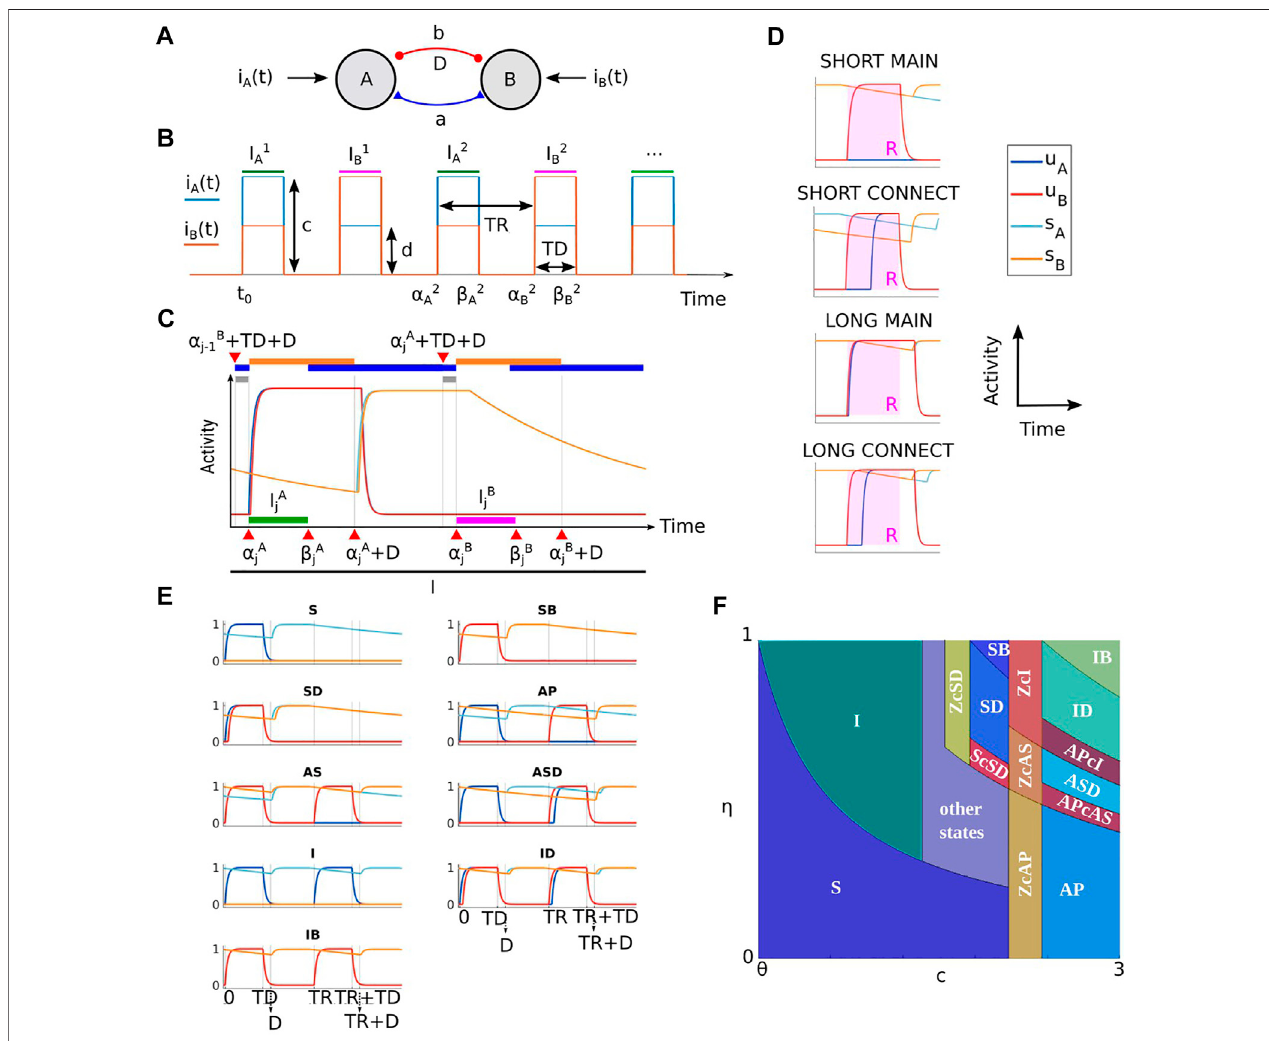
FIGURE1|(A) Sketchofthemodelcircuit:twoneuralpopulations(Aand B)aremutually connectedbyexcitation andinhibitionwithstrengths a and b .Inhibitionis delayed of the amount D . (B) Input to A and B populations are square-wave functions i A ( t ) and i B ( t ), respectively. These inputs mimic primary auditory cortical responses to sequences ofinterleaved Aand Btoneswithduration TD and presentation rate PR (the repetition time TR istheinverse of PR ).Parameters c isthelocal inputstrength fromA(B)locationstounitA(B).Parameters d isthelateralinputstrengthfromB(A)locationstounitA(B). (C) Exampledynamicsforasolutionofsystem(1)ina2 TR interval I (black interval) shows the subdivision into different intervals where the units ’ dynamics is constrained (colored intervals, see Theorem 1). (D) . Classi fi cation of statesbasedonthedynamicsduringanactivetoneinterval R ∈ Φ . (E) .Timehistoriesfor2 TR -periodicMAINSHORTstates. (F) .Existenceregionsfor2 TR -periodicMAIN and CONNECT states at varying ( c , η ). Parameters in panels E and F are TD (cid:2) 0.025, D (cid:2) 0.03, PR (cid:2) 17, a (cid:2) 0.6, b (cid:2) 2, θ (cid:2)